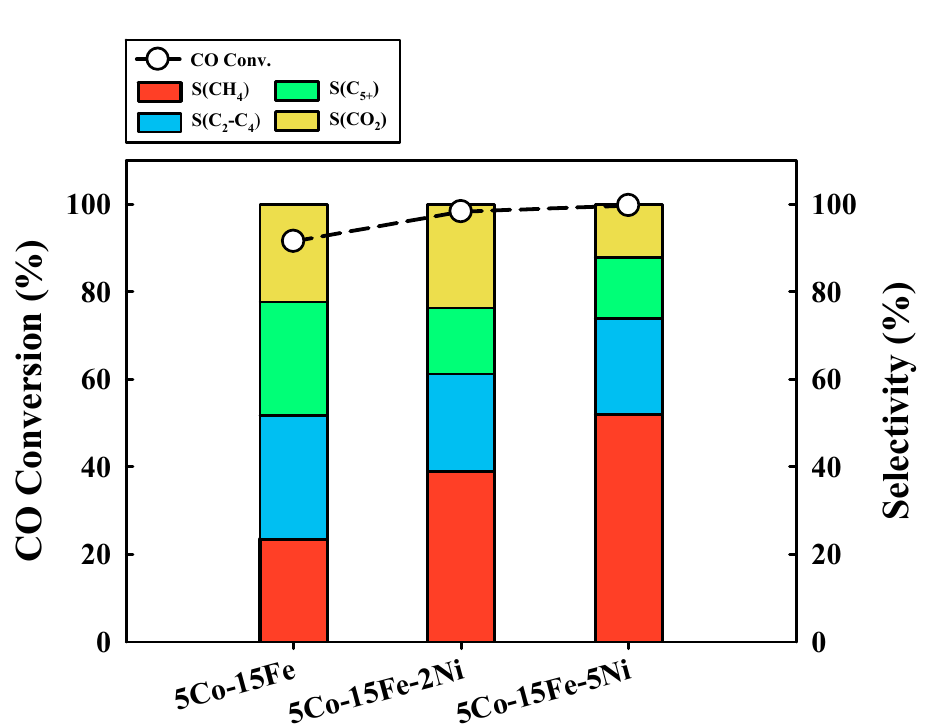
Figure 5. CO conversion and product selectivity in the Fe-Co and Fe-Co-Ni catalysts.